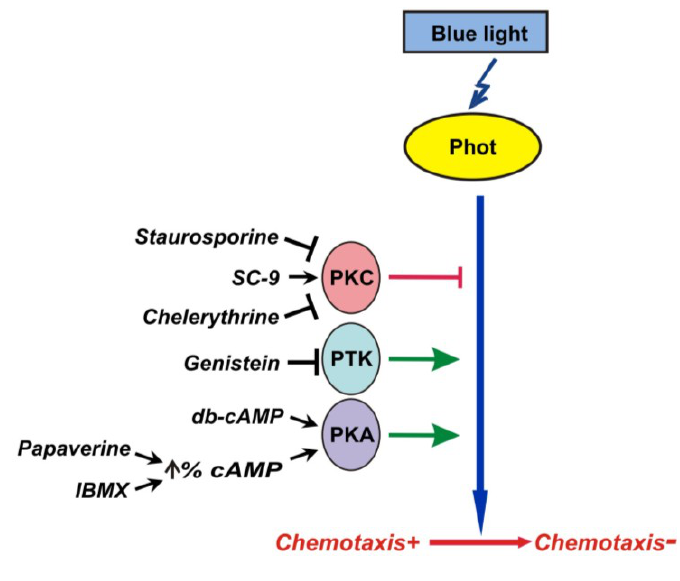
Figure 8. A model for the signaling pathway by which blue light controls chemotaxis towards nitrogen sources in C . reinhardtii during pregamete-to-gamete conversion. Black arrows indicate a stimulating effect of pharmacological compounds, T-lines indicate an inhibiting effect. Green arrows indicate stimulation of switch-off of chemotaxis, red T-line indicates exhibiting of switch-off of